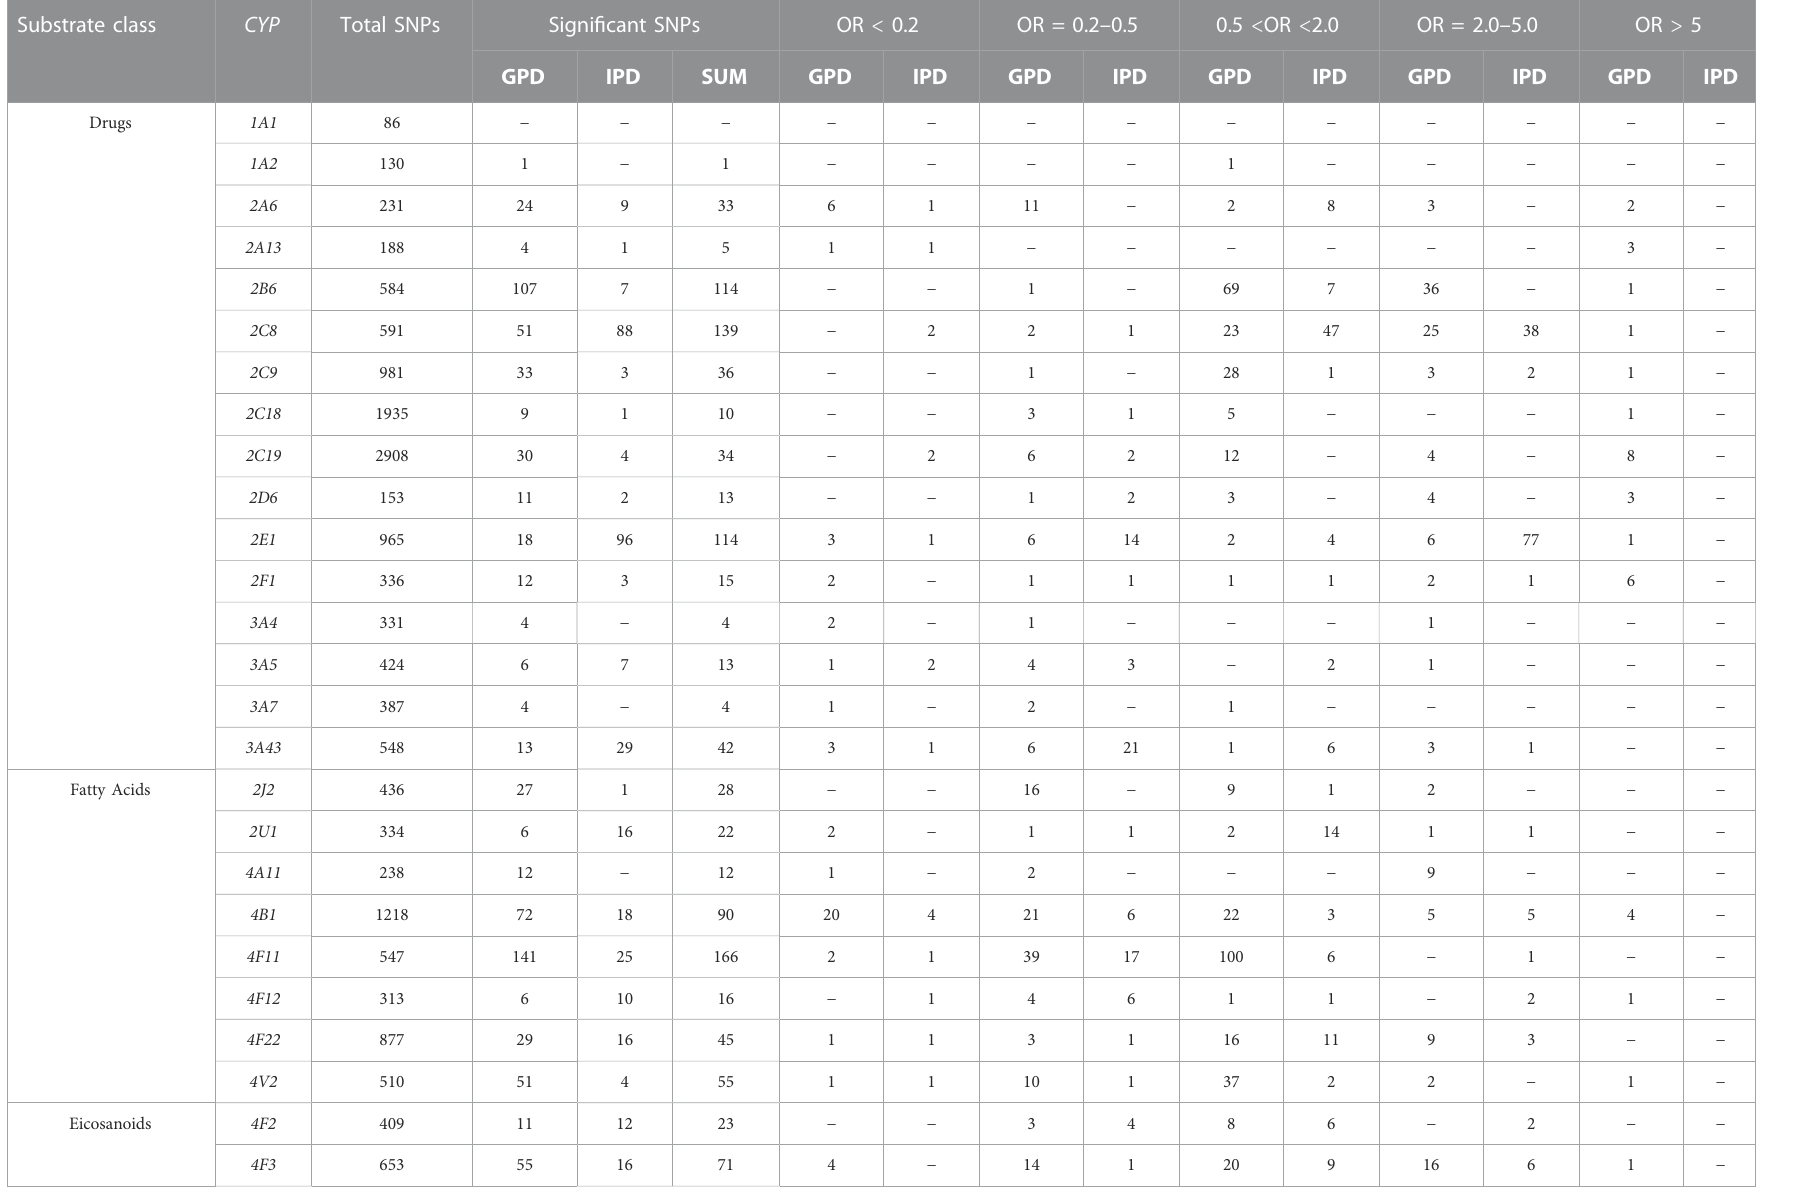
TABLE2Summaryof signi fi cantSNPsin57cytochrome P450sandthreeredoxpartners. CYP :cytochrome P450gene;GPDandIPD displaythe numbersofsigni fi cant SNPsfound inpatients sufferingfrom GPDor IPD,respectively; number of total SNPs shows the number of all SNPs (signi fi cant and non-signi fi cant) found in the corresponding gene. Signi fi cant means with p < 0.01 or 0.05. The data are subdivided according to the function of the individual SNPs as described by Guengerich (Guengerich,